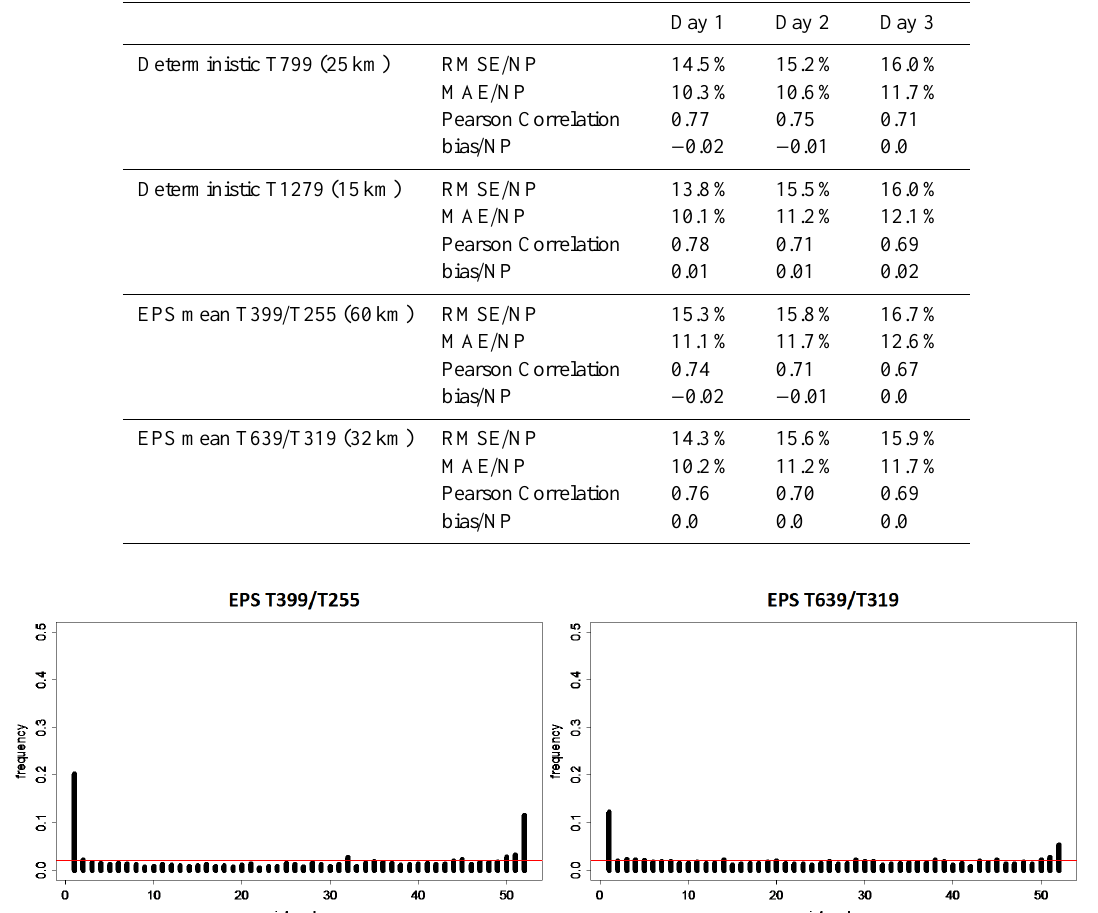
forecast run updated every 24h.